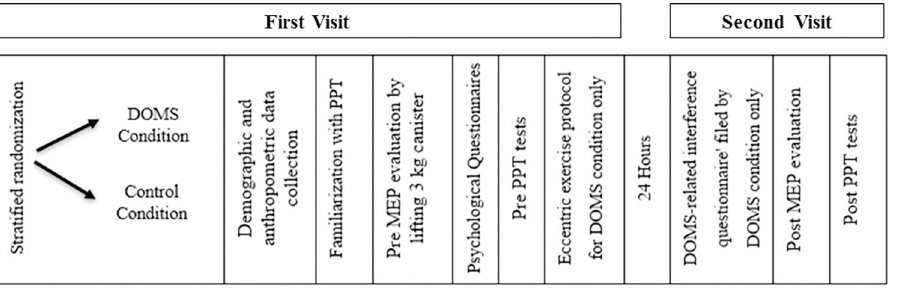
Fig 1. Flow chart of study